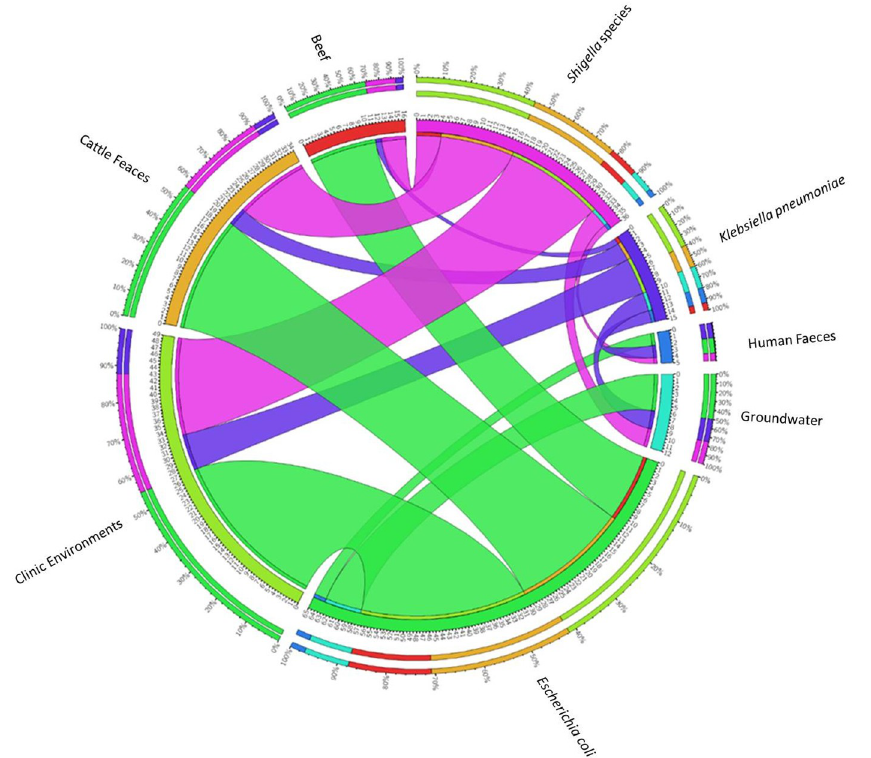
Fig 1. Summarized results of PCR-identified isolates from various